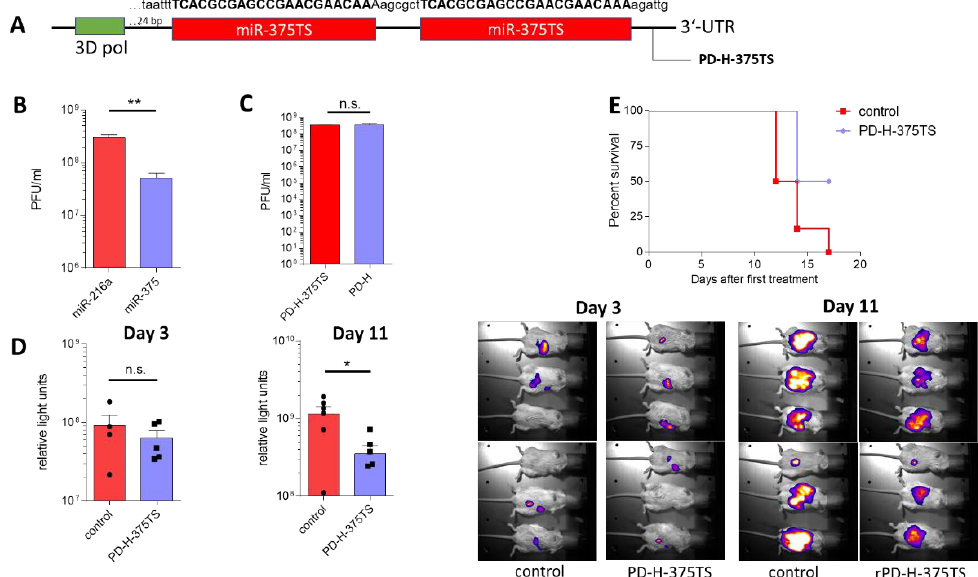
Figure 5. Oncolytic activity of PD-H-375 against intra-abdominal growing CT-26 tumors. ( A ) Scheme of miR-375TS region within the genome of PD-H-375TS. Two copies of the miR-375TS, separated by a 6 nucleotide long spacer, were inserted into the 3 (cid:48) -UTR of PD-H 24 bp downstream of the 3D polymerase encoding sequence. The miR-375TS are 100% complementary to the pancreas-specific expressed miR-375. The sequence of miR-375TS is shown in capitals. ( B ) Silencing of PD-H-375TS by miR-375. HEK293T cells were transfected with pCMV-miR-216a or pCMV-miR-375 and infected 48 h later with 0.1 MOI PD-H-375TS. Twenty-four hours later virus titers were determined by plaque assay. Shown are mean values ± SEM from two experiments performed, each in triplicate. Significance: ** p < 0.01. ( C ) Comparison of PD-H-375TS and PD-H replication in CT-26Luc cells. HEK293T cells were seeded in 24-well plates and infected with PD-H or PD-H-375TS at an MOI of 1. Twenty four hours later the viruses were isolated and the virus titers determined by plaque assay. ( D ) Oncolytic activity of CVB3-PD-375TS in tumor model of i.p. growing CT-26Luc tumors. The 3 × 10 5